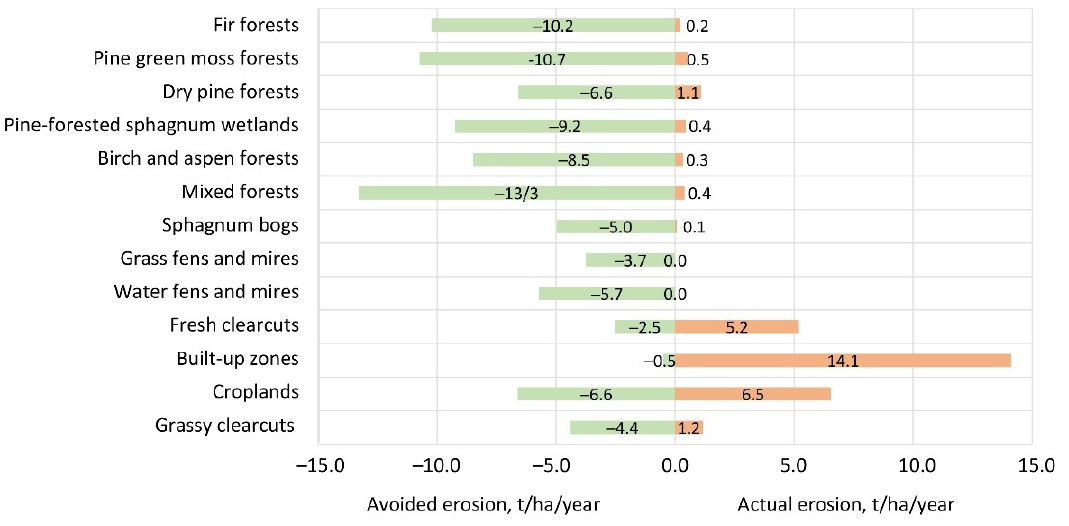
Figure 7. Contribution of different land-cover types to the ES of prevention of soil erosion: actual (orange bars) and avoided erosion (green bars).